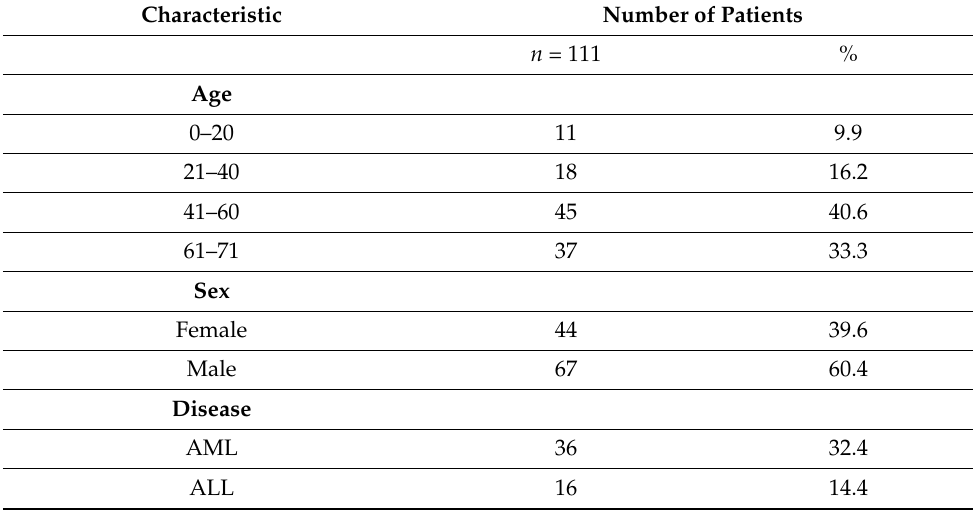
Table 1. General characteristics of allo-HCT patients admitted to the